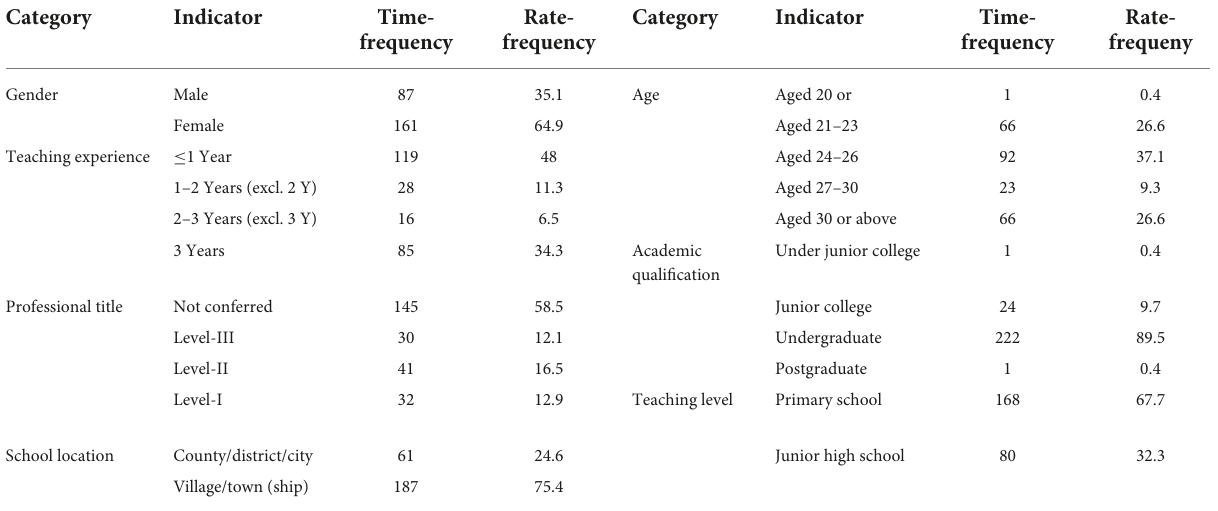
TABLE 1 Composition of samples ( N =